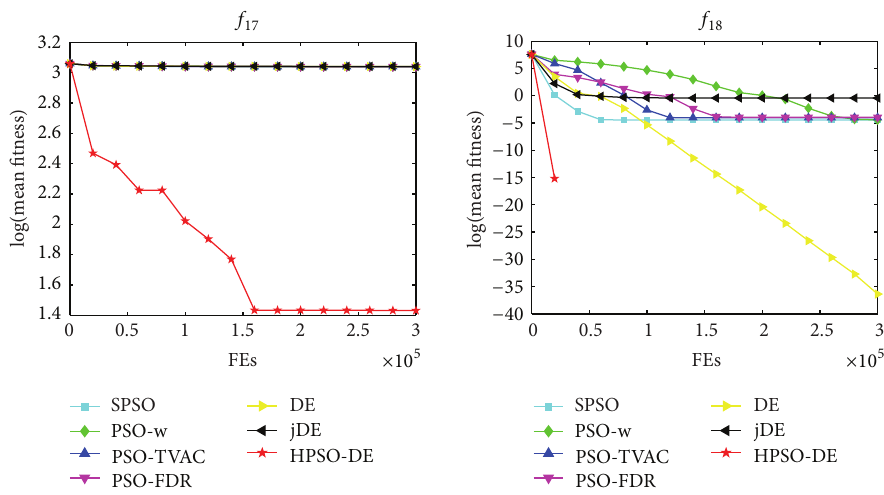
Figure 3: Performance of the algorithms for 𝑓 17 and 𝑓 18 .